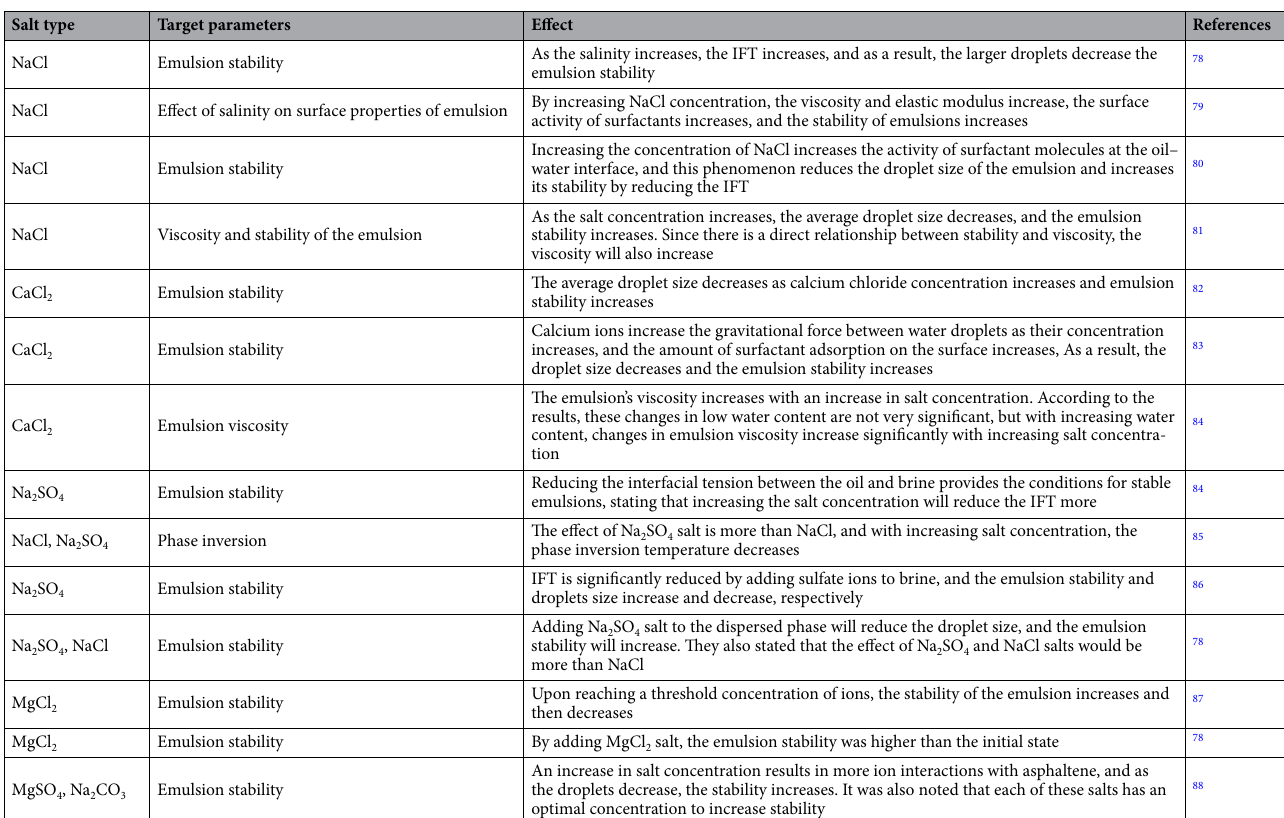
Table 5. Effect of salt on emulsion